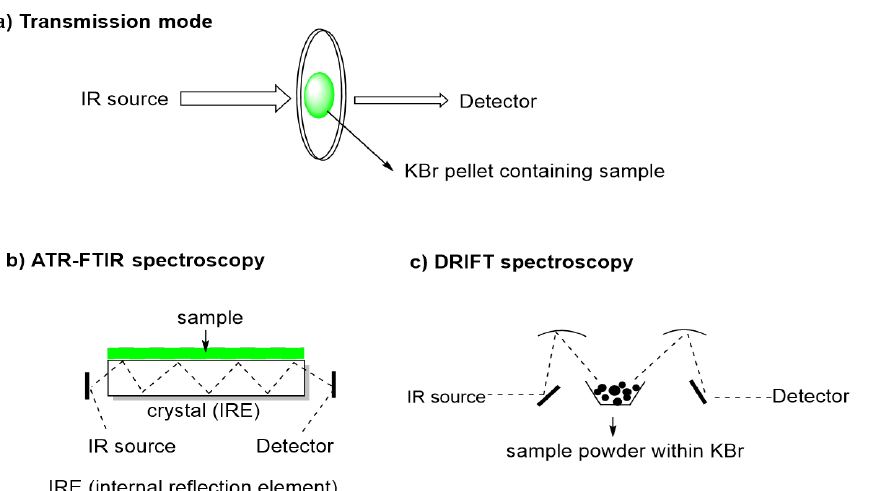
Figure 2. Sample presentation techniques for vibrational spectroscopy.